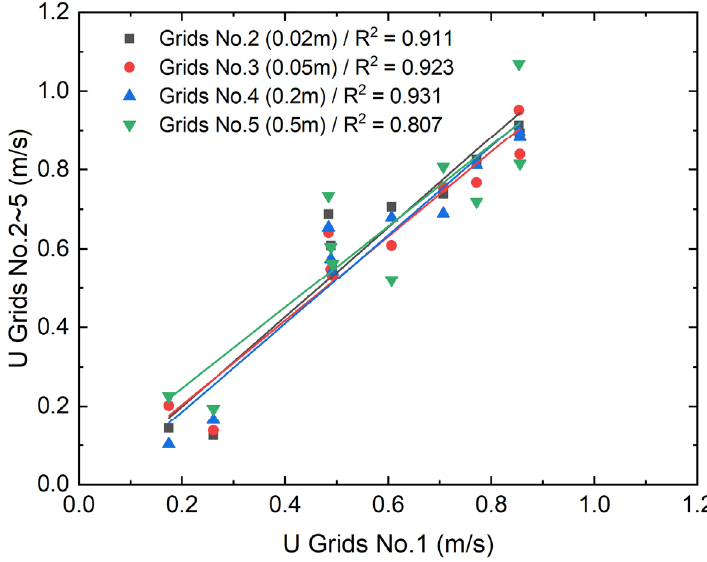
Figure 6. Comparison of the different grids concerning area-weighted wind velocity.